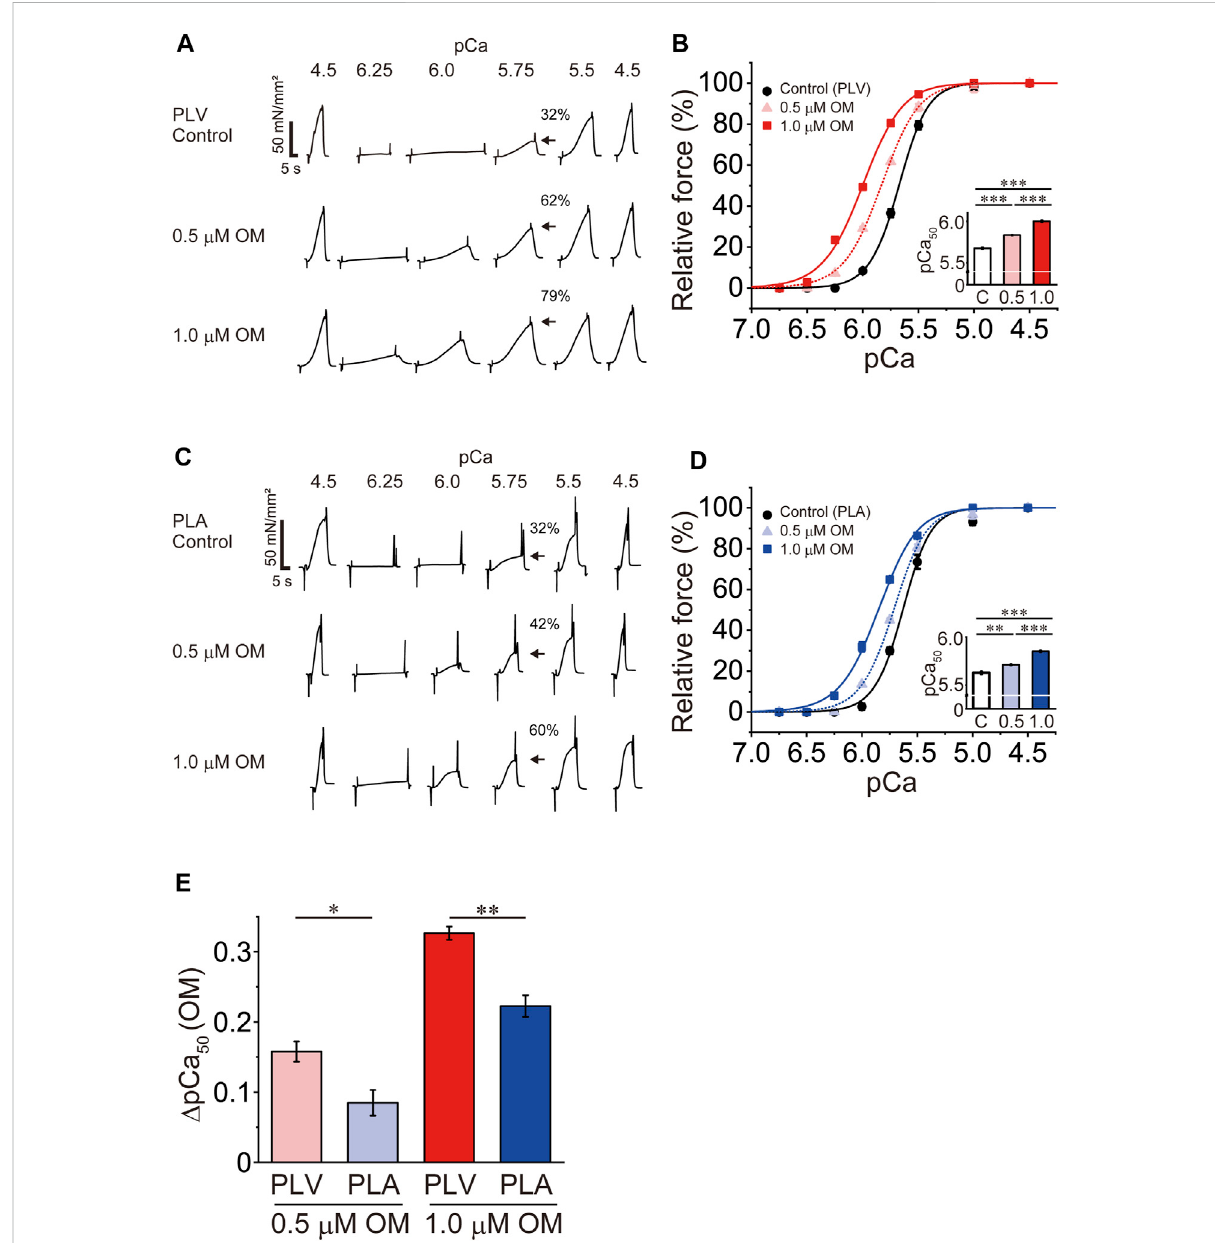
FIGURE 1 EffectsofOMonCa 2+ sensitivityinPLVandPLA. (A) Typicalchartrecordingshowingforce-pCaprotocolsinPLVintheabsenceandpresenceof OM at 0.5 and 1.0 μ M (in this order). Arrows indicate the percentage of active force at pCa 5.75 compared with the maximum obtained at the end of experiment (pCa 4.5). Note that OM increased submaximal force (i.e., at pCa 6.25, 6.0, 5.75 and 5.5). SL was set at 2.1 μ m. Control, without OM. (B) Force-pCacurvesshowingtheeffectsofOMat0.5and1.0 μ MonCa 2+ sensitivityinPLV.Blackcirclesandsolidlines,control(withoutOM);light red triangles and dotted lines, 0.5 μ MOM; red squares and solidlines, 1.0 μ M OM. Inset, pCa 50 valuesin theabsence and presence of OM. C, control (without OM); 0.5, 0.5 μ M OM; 1.0, 1.0 μ M OM. *** p < 0.001 (Tukey-Kramer test). n = 6 for all groups. (C) Same as in (A) for PLA in the absence and presence of OM at 0.5 and 1.0 μ M (in this order). Arrows indicate the percentage at pCa 5.75 compared with the maximum obtained at the end of experiment(pCa 4.5). Note that OM increased submaximal force (i.e., atpCa 6.25, 6.0, 5.75 and 5.5) [as in PLV; see (A) ]. SL was set at 2.1 μ m. Control, without OM. (D) Same as in (B) for PLA showing the effects of OM at 0.5 and 1.0 μ M on Ca 2+ sensitivity. Black circles and solid lines, control (without OM); light blue triangles and dotted lines, 0.5 μ M OM; blue squares and solid lines, 1.0 μ M OM. Inset, pCa 50 values in the absence and presence of OM.C,control(withoutOM);0.5,0.5 μ MOM;1.0,1.0 μ MOM.** p < 0.01;*** p < 0.001(Tukey-Kramertest). n =5forallgroups. (E) Graphcomparing the Ca 2+ -sensitizing effect of OM ( Δ pCa 50 ) between PLV and PLA at 0.5 and 1.0 μ M. At both concentrations, Δ pCa 50 was greater for PLV than PLA. * p < 0.05; ** p < 0.01 (unpaired Student ’ s t